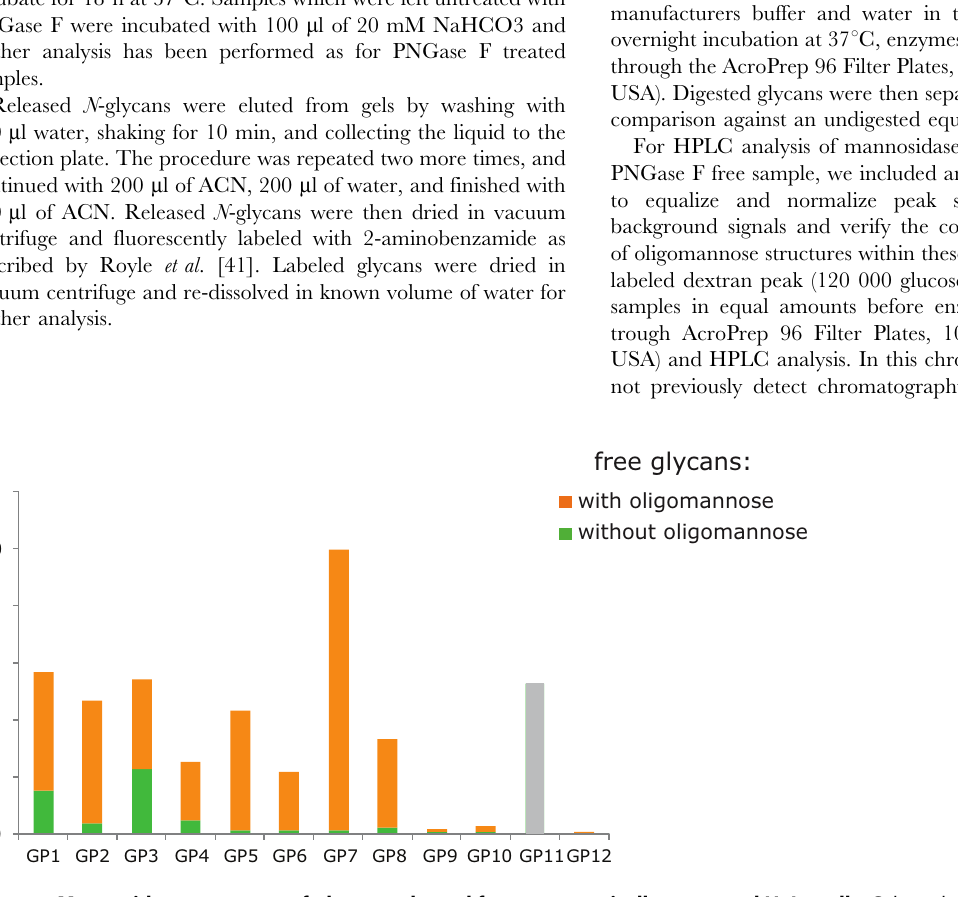
Figure 4. Mannosidase treatment of glycans released from enzymatically untreated HeLa cells. Column height of each individual glycan group is normalized to the highest one, set to 100 (GP7). Gray column (GP11) represents an internal standard (2-aminobenzamide labeled dextran peak) added in order to equalize and normalize peak signals, correctly interpret background signals and verify the composition and percentages of oligomannose structures within these